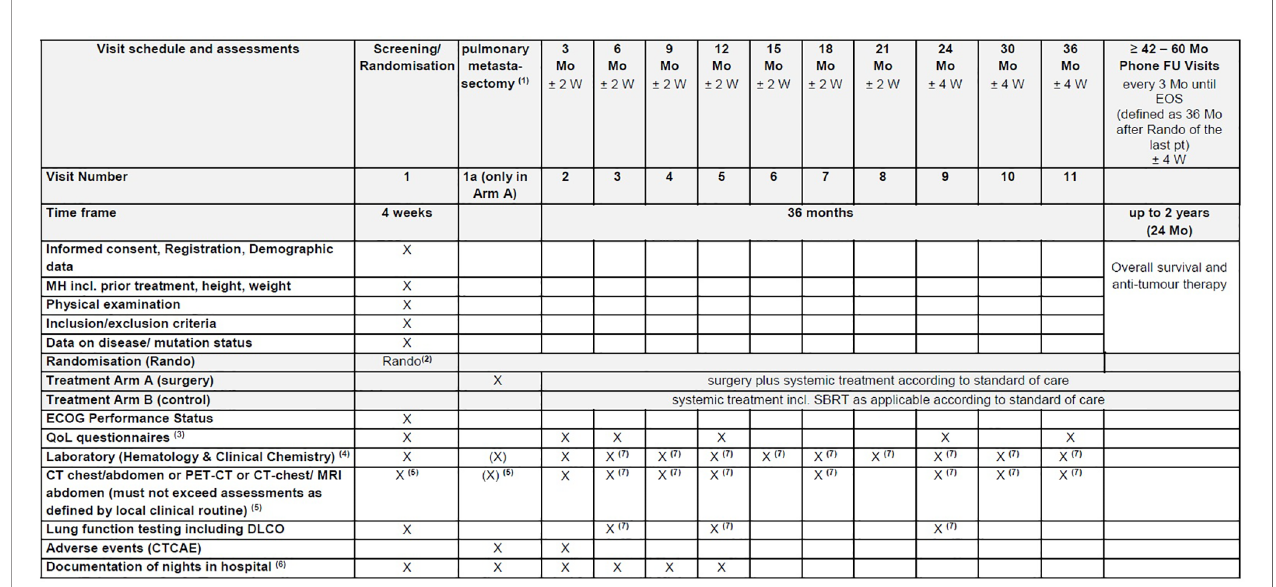
FIGURE 2 | EOS, End of Study; FU, Follow-Up; MH, Medical history; Mo, month(s); pt(s), patient(s); Rando, randomisation; SBRT, Stereotactic Radiation Therapy; W, week(s). (1) Investigations during the treatment period are performed at the discretion of the treating physician and according to the respective treatment arm. (2) Randomisation has to be performed as close as possible to potential start of surgery. (3) Quality of life (QoL) will be assessed using the EORTC QLQ-C30, QLQ- CR29 and QLQ-LC29 questionnaires. (4) Laboratory includes LDH, CEA, CA19-9, CRP (see section 7.8.8 Blood tests). (5) Not older than 6 weeks at the time of randomisation. (6) Number of nights in hospital will be documented starting from the randomisation date and until the end of the month 12. (7) Might be assessed externally, if not possible at trial site due to